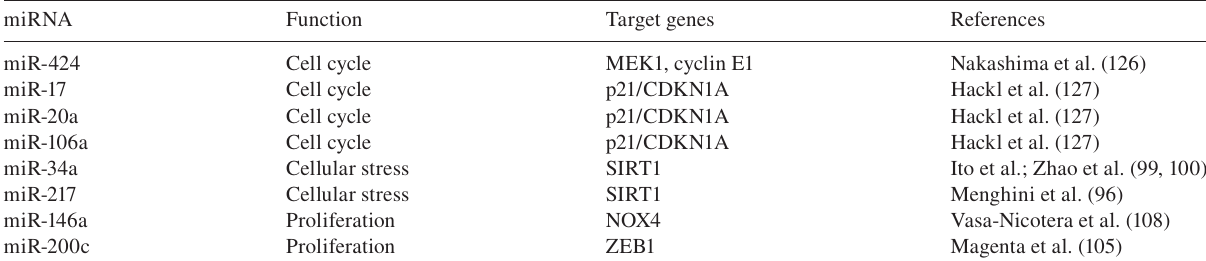
Table 2 miRNAs associated with endothelial